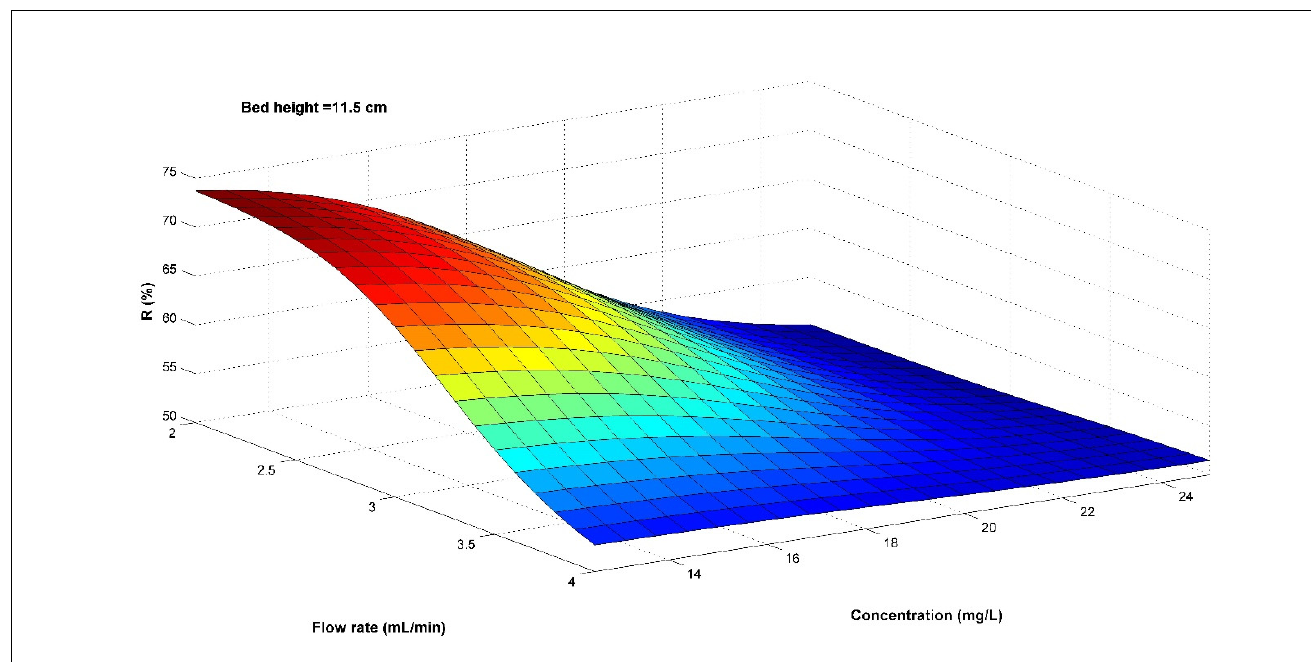
Figure 2. Surface graphs for cobalt removal (%): ( a ) inlet concentration vs. bed height at constant feed-flow rate, ( b ) feed-flow rate vs. bed height at constant inlet concentration, ( c ) inlet concentration vs. feed-flow rate at constant bed height.